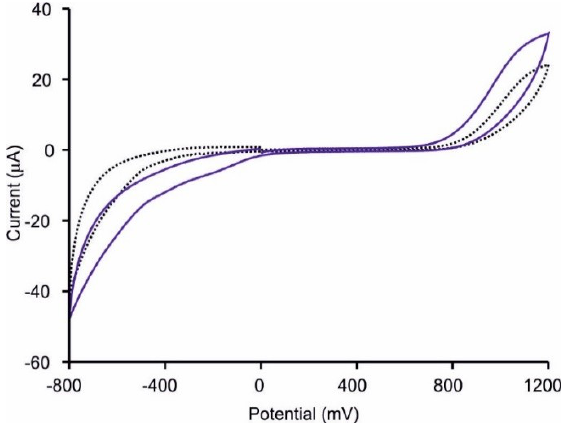
Figure 6. Cyclic voltammograms of [CHI-IL/CuPc S ] 2 (dotted black line ), and for [CHI-IL/CuPc S ] 2 -GAO (solid blue line ) sensor immersed in sample SSnolac 2 . Scan rate 100 mV ·s −1 .